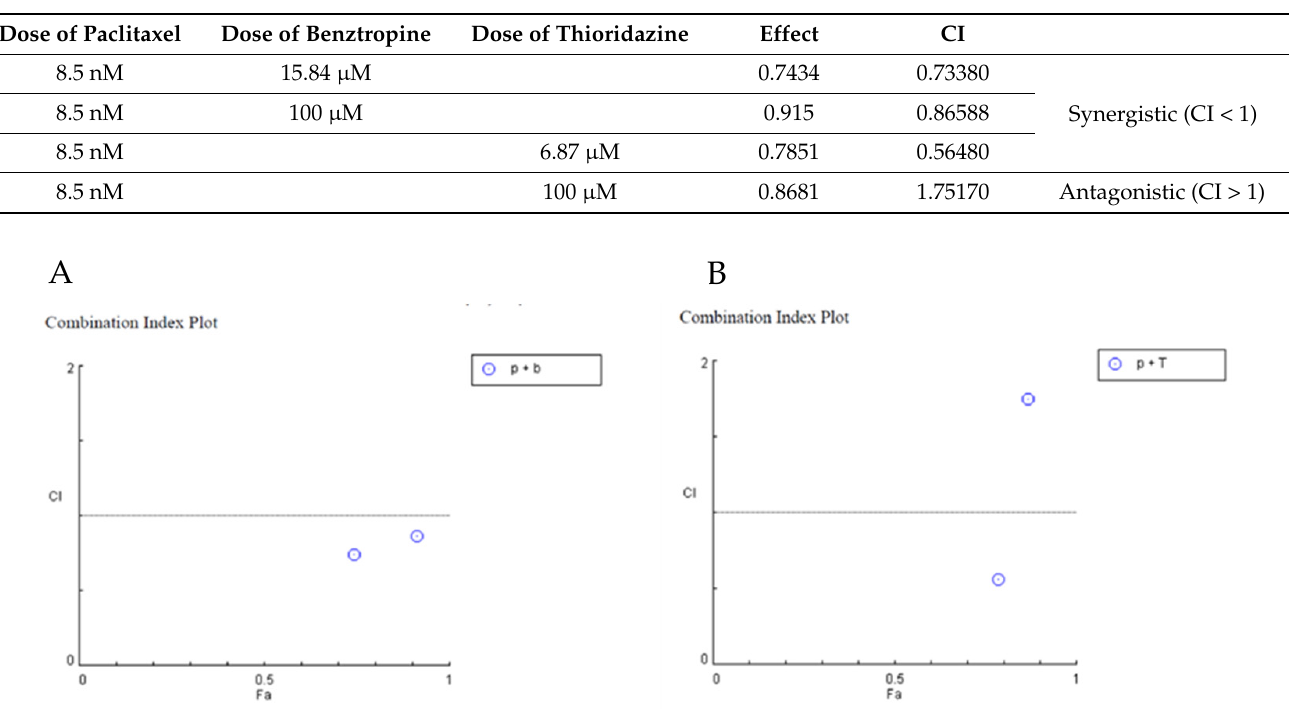
Figure 19. Chou-Talalay method Fa-CI plot of ( A ) paclitaxel and benztropine and ( B ) paclitaxel and thioridazine. CI was plotted on the y-axis as a function of effect level (Fa) on the x-axis to assess drug synergism. CI < 1, CI = 1 and CI > 1 indicate synergism, additivity and antagonism, respec- tively.